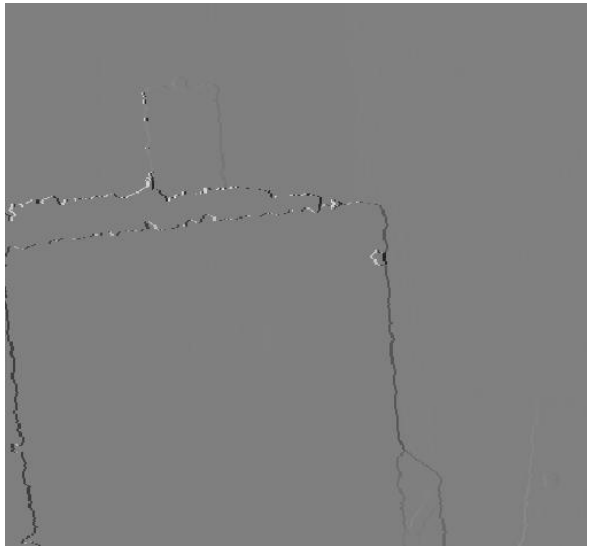
Figure 8. Boundaries are determined as a class in simple scenes.